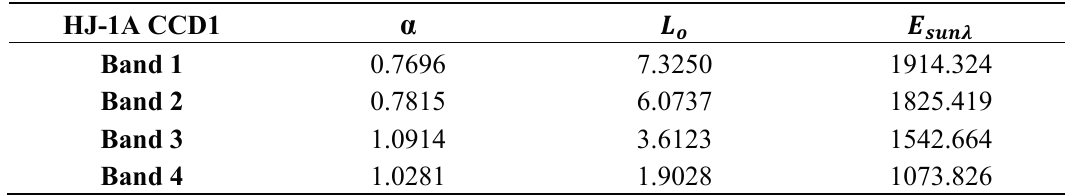
Table 1. Absolute radiometric calibration coefficient and exoatmospheric solar irradiance for HJ-1A